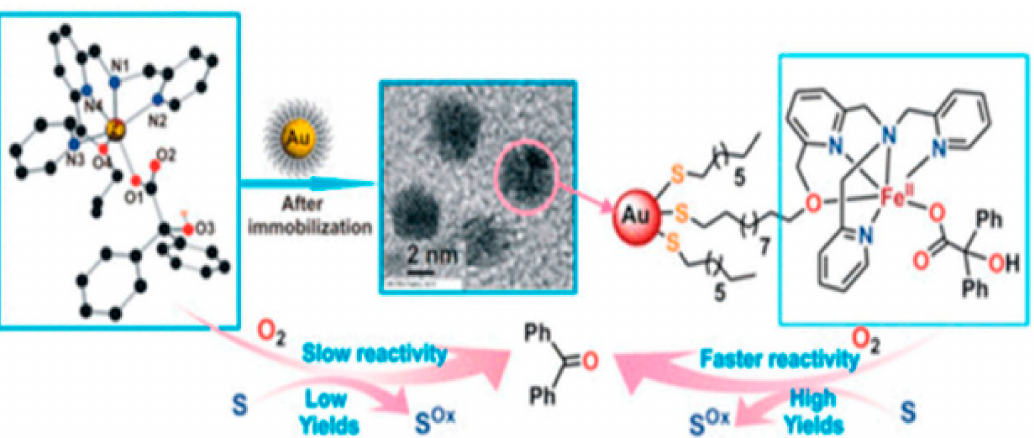
Figure 20. Description of the ability of oxidizing agent of a dioxygen-activating from complex of non heme Iron(II)-Benzilate immobilized on Au NPs, reproduced with permission from reference [150], ACS, 2019.